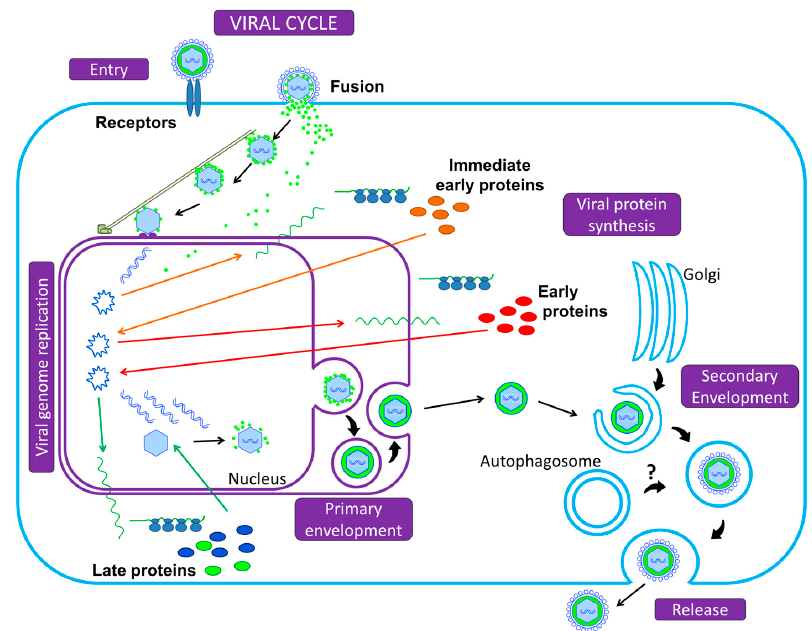
Figure 1. Summary of the Herpesvirus replication cycle. Initiation of infection begins with the adsorption of the viral particle to cell surface receptors and the virus enters the cell either by fusion of its envelope with the plasma membrane or by endocytosis, releasing the capsid and the tegument into the cytoplasm. Using the microtubule network, the nucleocapsid is transported to the nuclear pore, where the viral genome is released into the nucleus and circularizes. The viral DNA serves as a template for Pol II and leads to the production of mRNAs, expressed in three successive and coordinated phases. mRNAs are translated in the cytoplasm into viral proteins ( α , or immediate-early; β , or early; and γ , or late proteins). Most of the late gene products contribute to the formation of the viral particle. DNA packaging into pre-assembled capsids takes place in the nucleus. This is followed by a primary envelopment of the nucleocapsids by budding through the inner nuclear membrane. The envelope of perinuclear virions then fuses with the outer nuclear membrane to release naked nucleocapsids into the cytoplasm (de-envelopment). Tegumented capsids acquire a “second” final envelope to become virions from post-Golgi membrane compartments. A role for autophagic membranes in envelopment and release of virions has been proposed for some herpesviruses. Once formed, virions are translocated to the cell surface within small vesicles using exocytosis machinery and released from the cells.